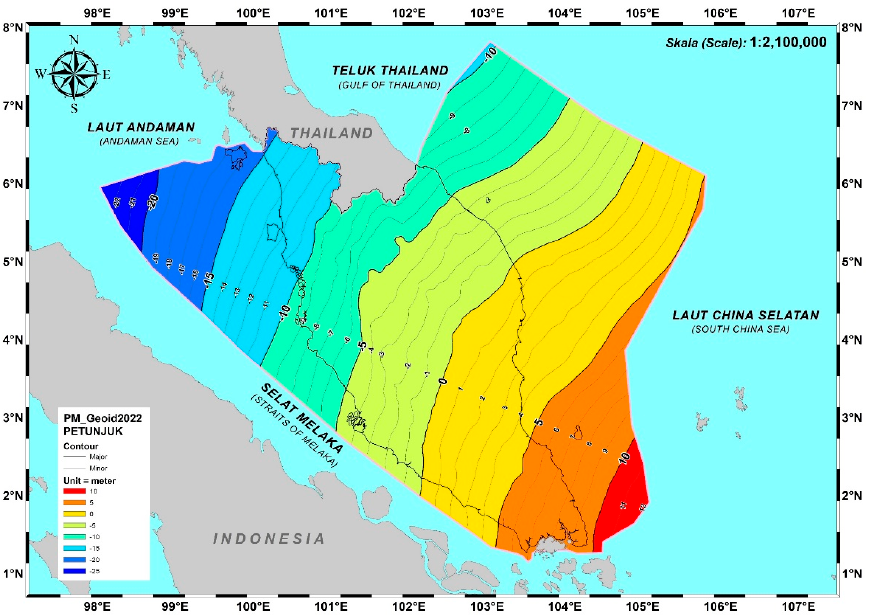
Figure 13. Gridded final gravimetric geoid for Peninsular Malaysia, PMGeoid2022 (CI = 1 m).